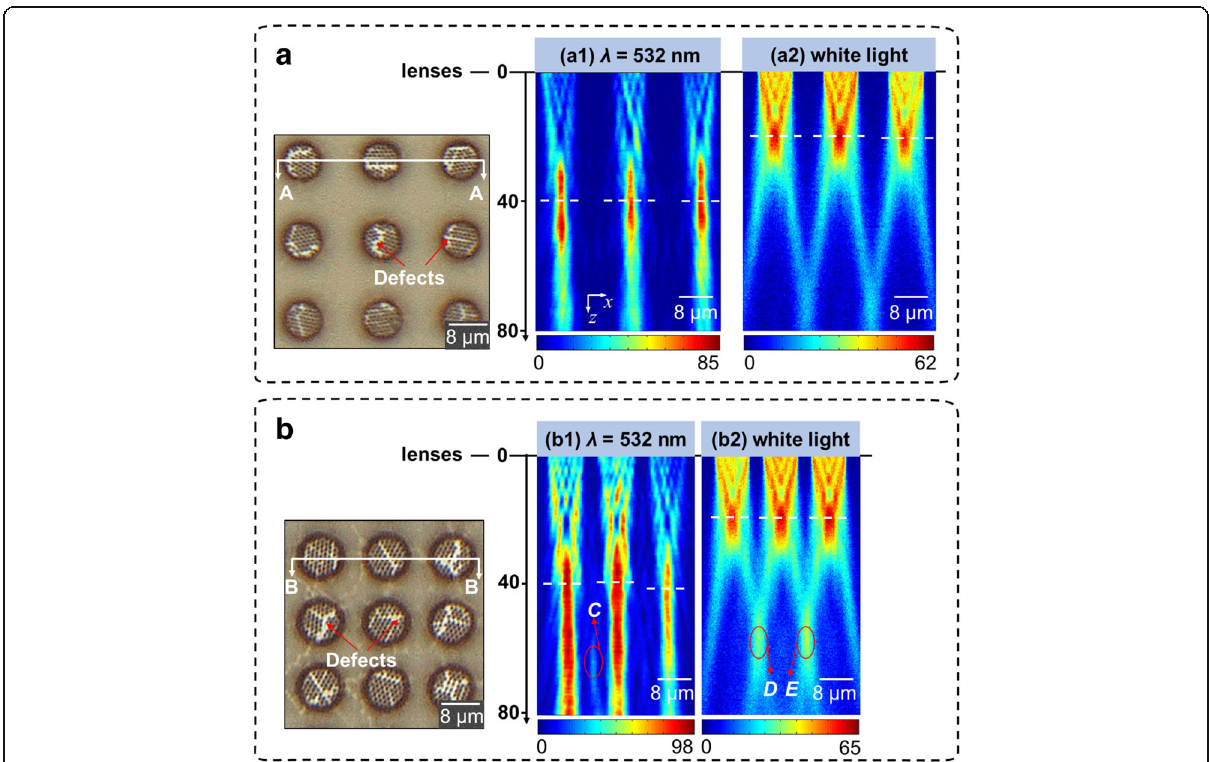
Fig. 8 a Optical microscope images for the fabricated 3×3 microlens array spacing 8 μ m apart when d =8 μ m and the measured optical patterns ( A – A ) under (a1) the single wavelength of λ = 532 nm and (a2) the broadband illumination. Identical foci from individual microlenses are observed. b Experimental results ( B – B ) for the 3×3 microlens array spacing 4 μ m under (b1) the single wavelength of λ =532 nm and (b2) the broadband illumination. The coupling effect between two adjacent microlenses, as denoted by the regions C , D , and E , can be